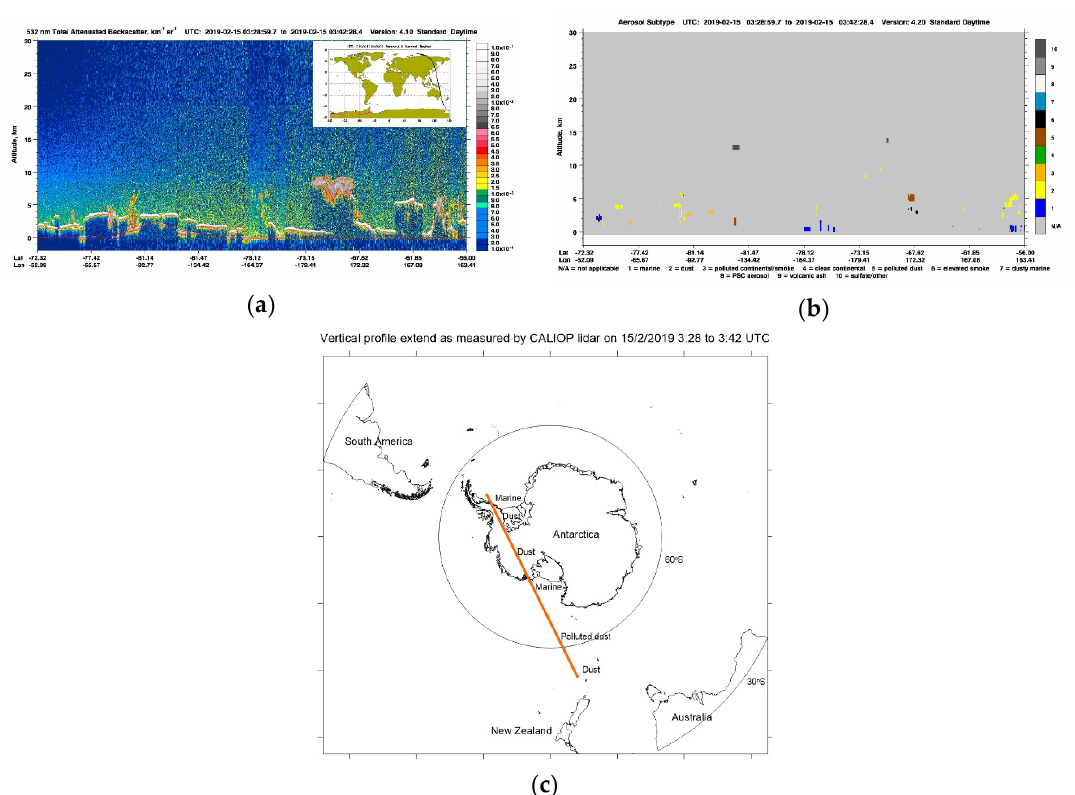
Figure 17. ( a ) LiDAR 532 nm total attenuated backscatter vertical structure on 15 February 2019 from 03:42 to 03:42 UTC with CALIPSO satellite path (inset) above Antarctica. ( b ) Aerosol subtype vertical profile as derived from CALIOP measurements ( c ) Extent of vertical profile as measured by CALIPSO satellite on 14 February 2019 (red line). The labels correspond to aerosol types at the location indicated.